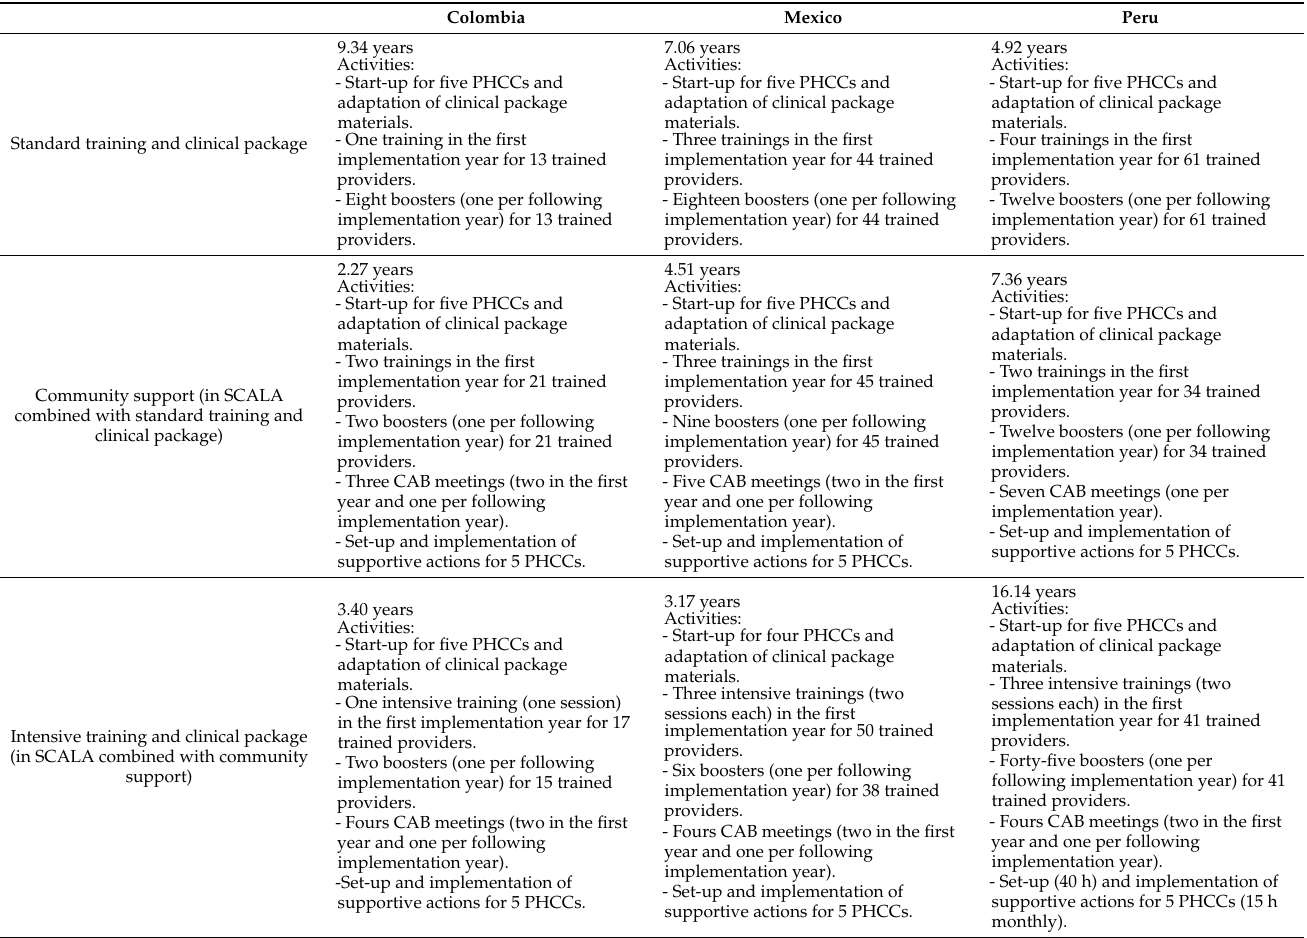
Table A5. Period within which 10,000 alcohol measurement sessions would be delivered in one SCALA study arm and corresponding number of implementation